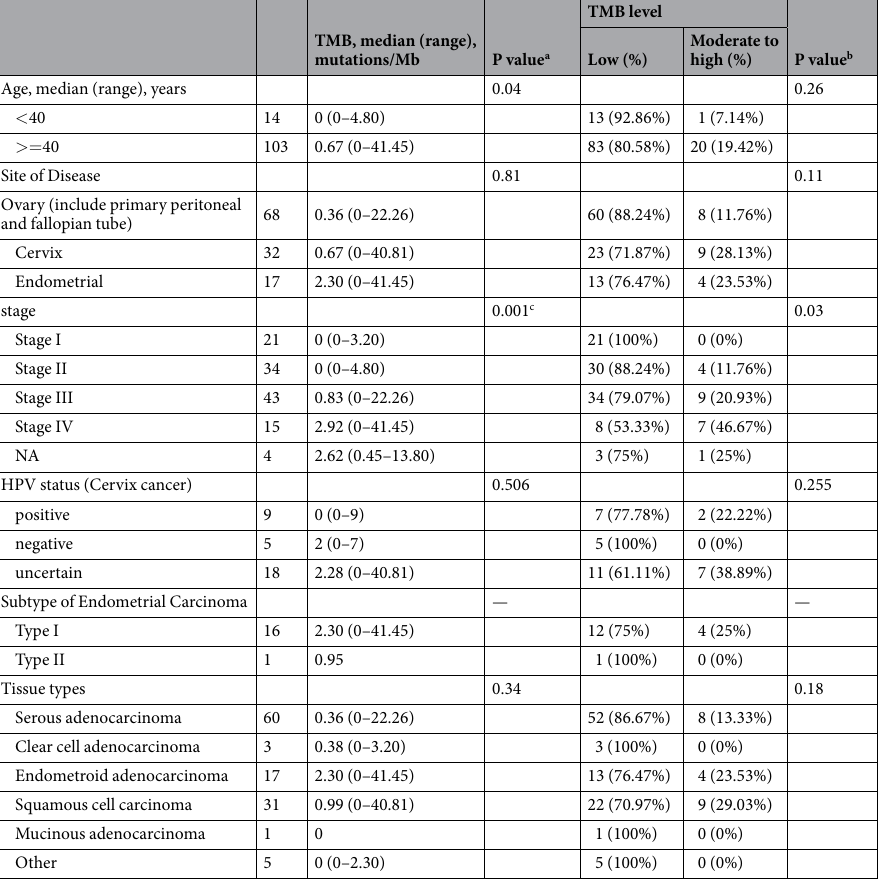
Table 2. The association of TMB levels and clinical status. Note: a calculated using Mann-Whitney